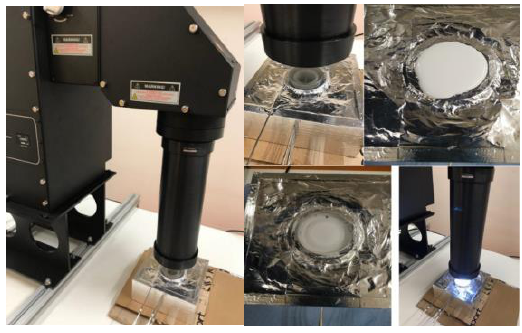
Figure 2. Photo-to-thermal conversion set-up.